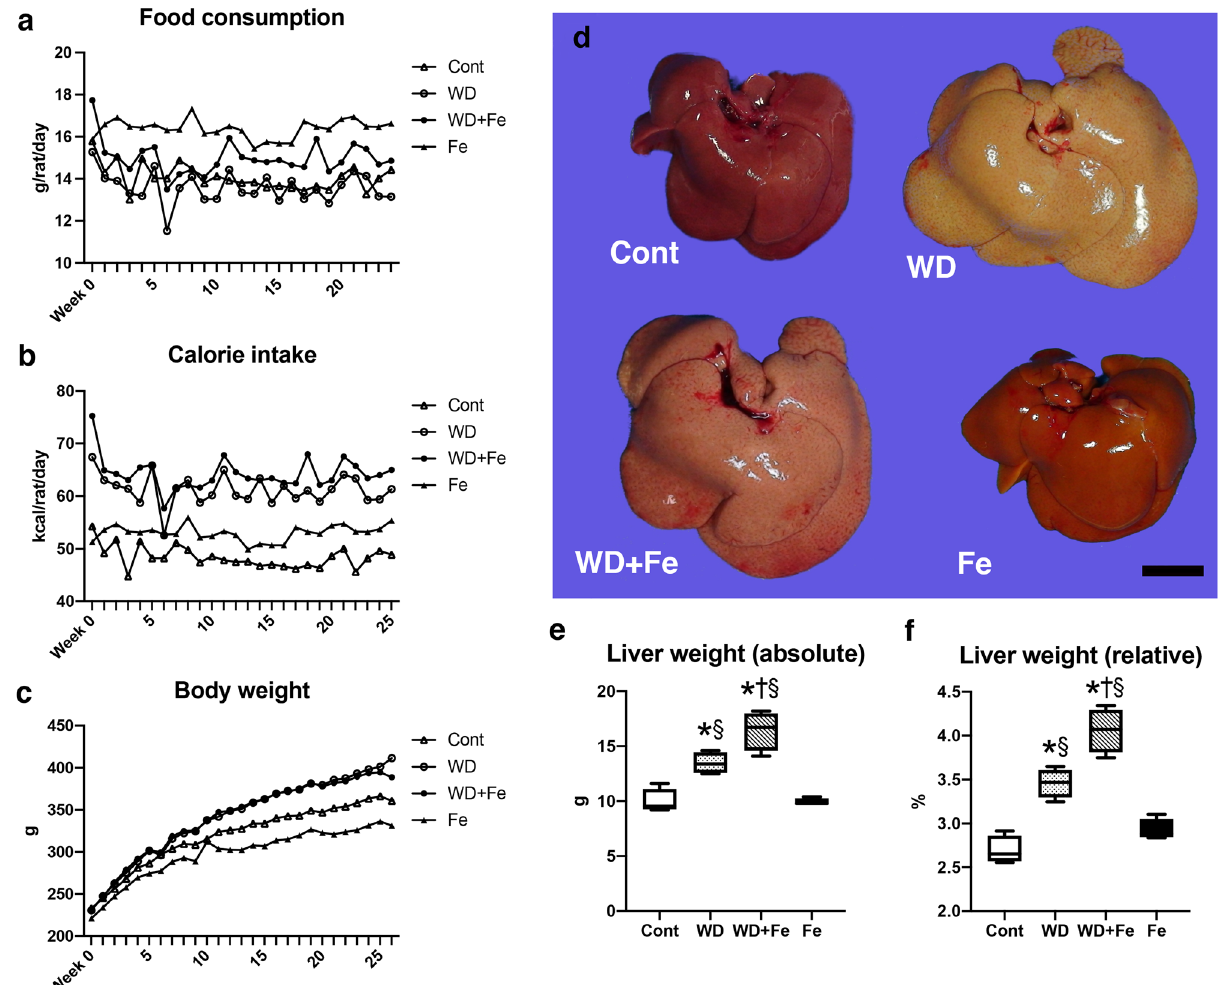
Figure 1. Temporal changes in ( a ) food consumption, ( b ) calorie intake and ( c ) body weight of control, WD, WD + Fe and Fe groups. Calorie intake was calculated by multiplying food consumption by estimated total calories of each diet shown in Supplementary Table 1. ( d ) Gross images of the livers of control, WD, WD + Fe, and Fe groups at week 26. Bar: 1 cm. ( e ) Absolute and ( f ) relative liver weight per 100 g body weight in control, WD, WD + Fe and Fe groups at week 26. Data are presented as box and whiskers (n = 4/group). * P < 0.05 versus Cont, † P < 0.05 versus WD, and § P < 0.05 versus Fe by one-way ANOVA followed by Tukey’s multiple